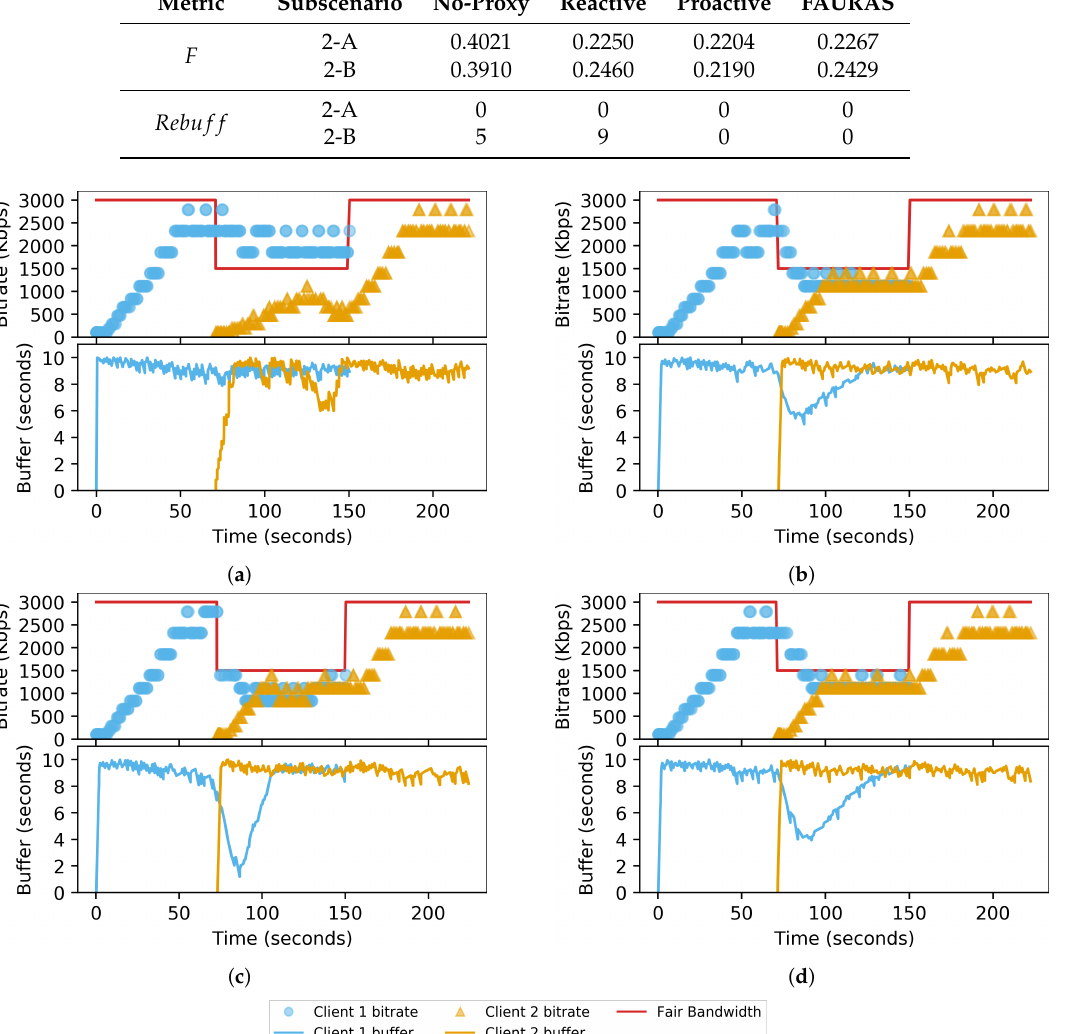
Figure 6. Time-varying performances of all methods in subscenario 2-A. ( a ) No-Proxy; ( b ) Reactive; ( c ) Proactive; ( d )